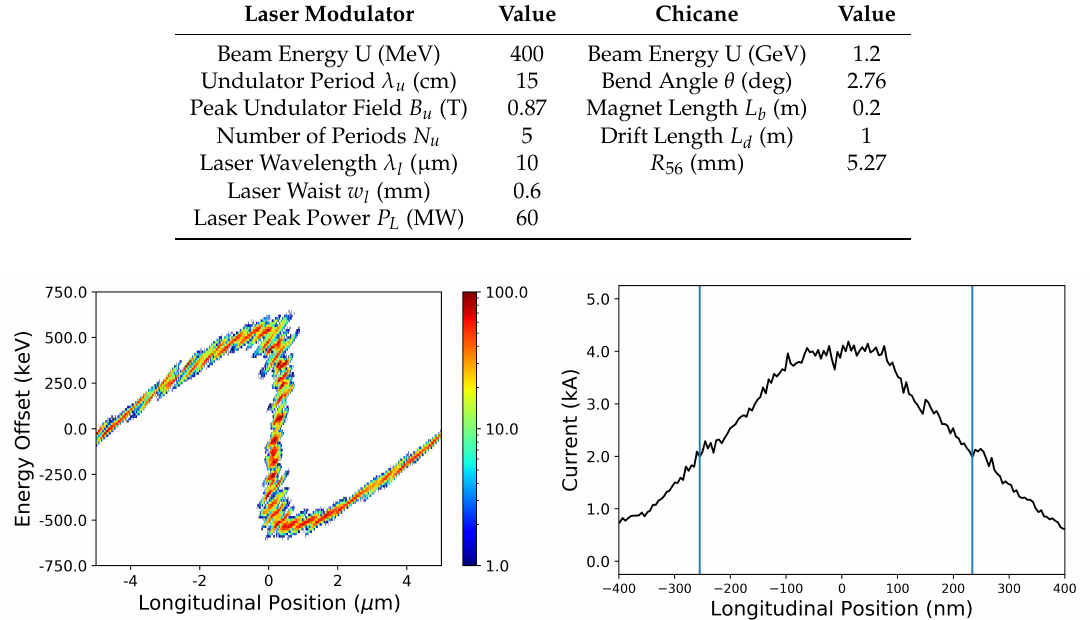
Table 3. The parameters for the laser modulator and final chicane are given for the optimal dimensionless modulation amplitude and compressor strength discussed in the text.